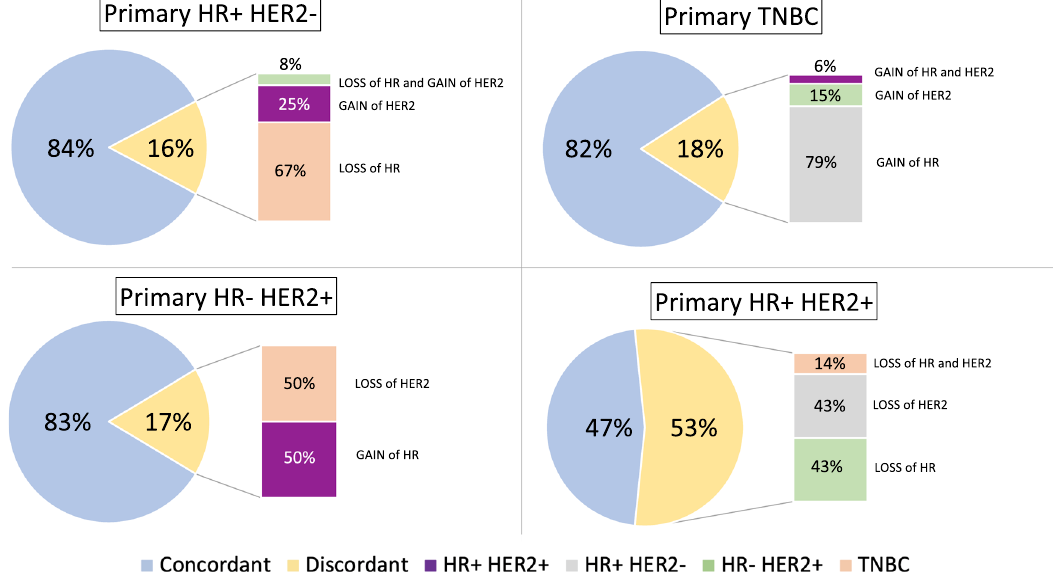
Fig. 3 Breast cancer subtypes on primary tumour and metastatic disease. Primary HR + HER2 − ( n = 641), Primary TNBC ( n = 181), Primary HR − /HER2 + ( n = 58), Primary HR + /HER2 + ( n = 92). HR Hormone receptor expression, HER2 human epidermal growth factor receptor 2 status, TNBC Triple negative breast